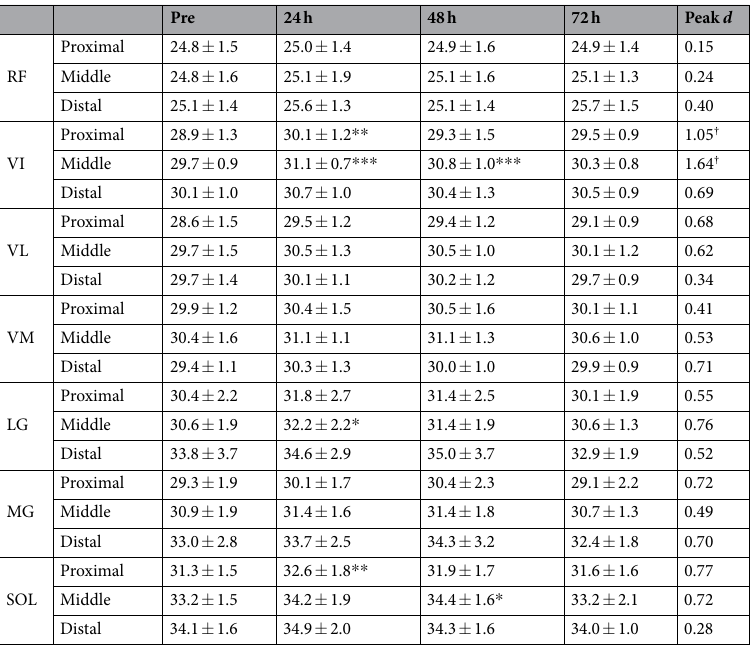
Table 3. T 2 values (ms) measured before and 24, 48, and 72 h after downhill running. * , ** , *** :Significantly different from pre at P < 0.05, P < 0.01, and P < 0.001, respectively. † The sites where Cohen’s d regarding T 2 change from pre was large ( d ≥ 0.8). RF: rectus femoris, VI: vastus intermedius, VL: vastus lateralis, VM: